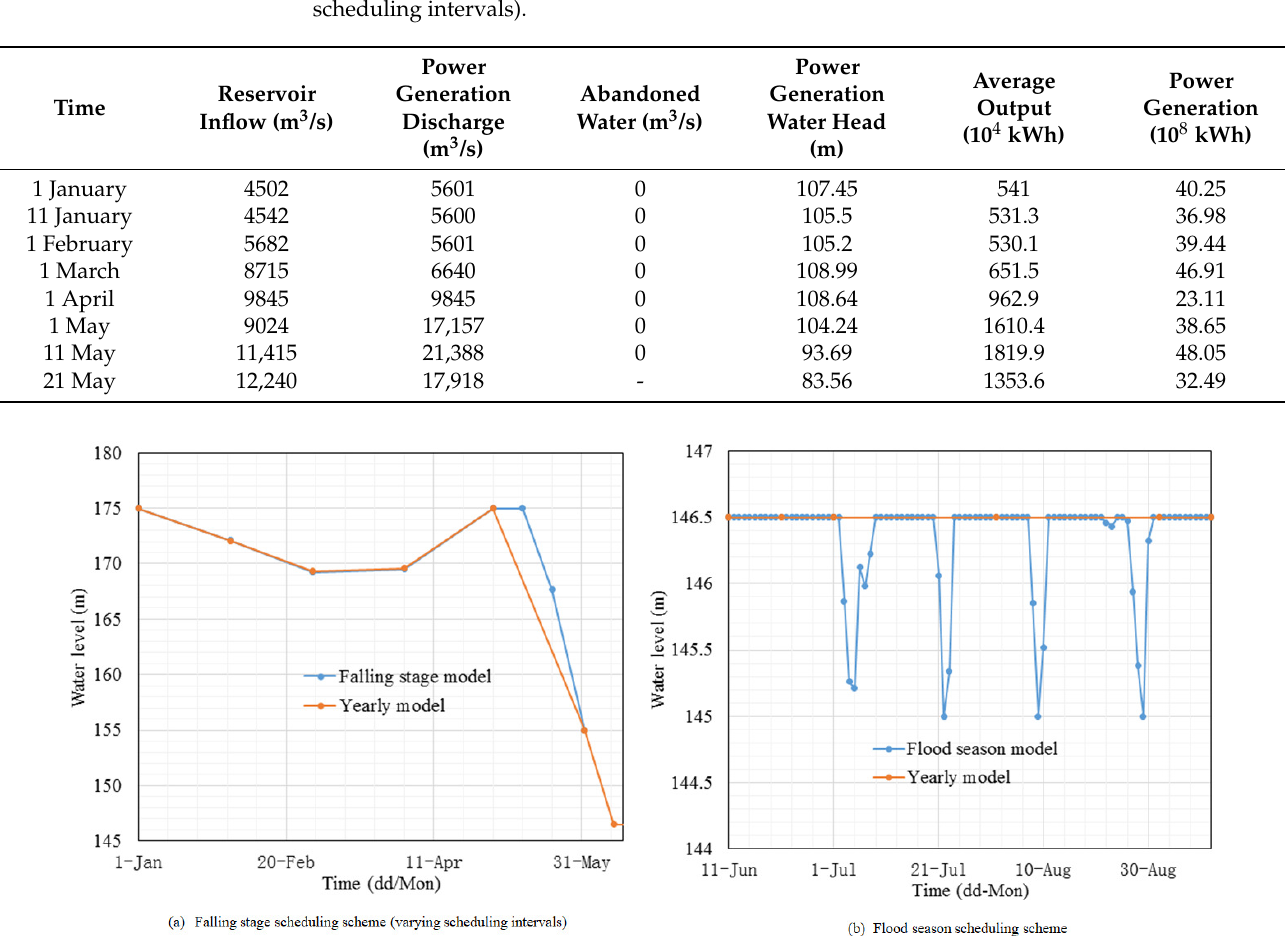
Table 5. Implementation effect statistics of falling stage scheduling scheme for TG reservoir (varying scheduling intervals).